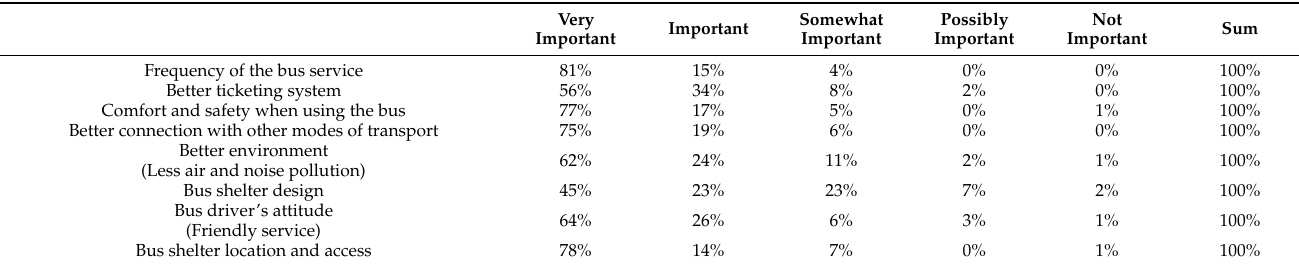
Table 3. Ranking of attributes according to their importance.